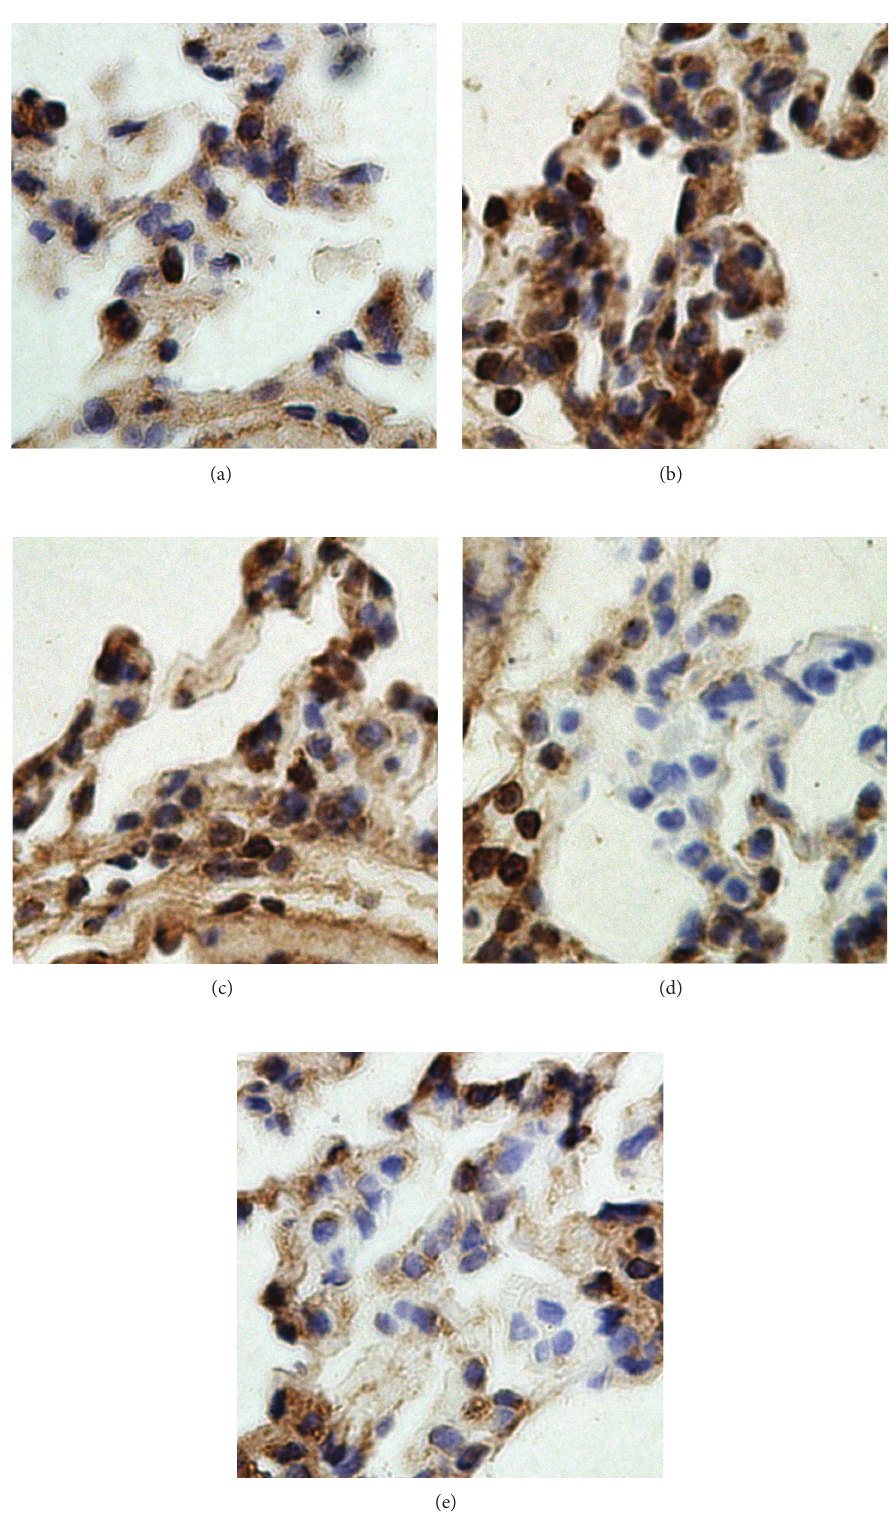
Figure 7: Effect of dexmedetomidine on NF- 𝜅 B p-65 activation in lung tissues of septic rats by immunohistochemistry staining. (a) Sham operation group; (b) cecal ligation and puncture operation group; (c) 5 𝜇 g/kg dexmedetomidine treatment group; (d) 10 𝜇 g/kg dexmedetomidine treatment group; (e) 20 𝜇 g/kg dexmedetomidine treatment group (magnification